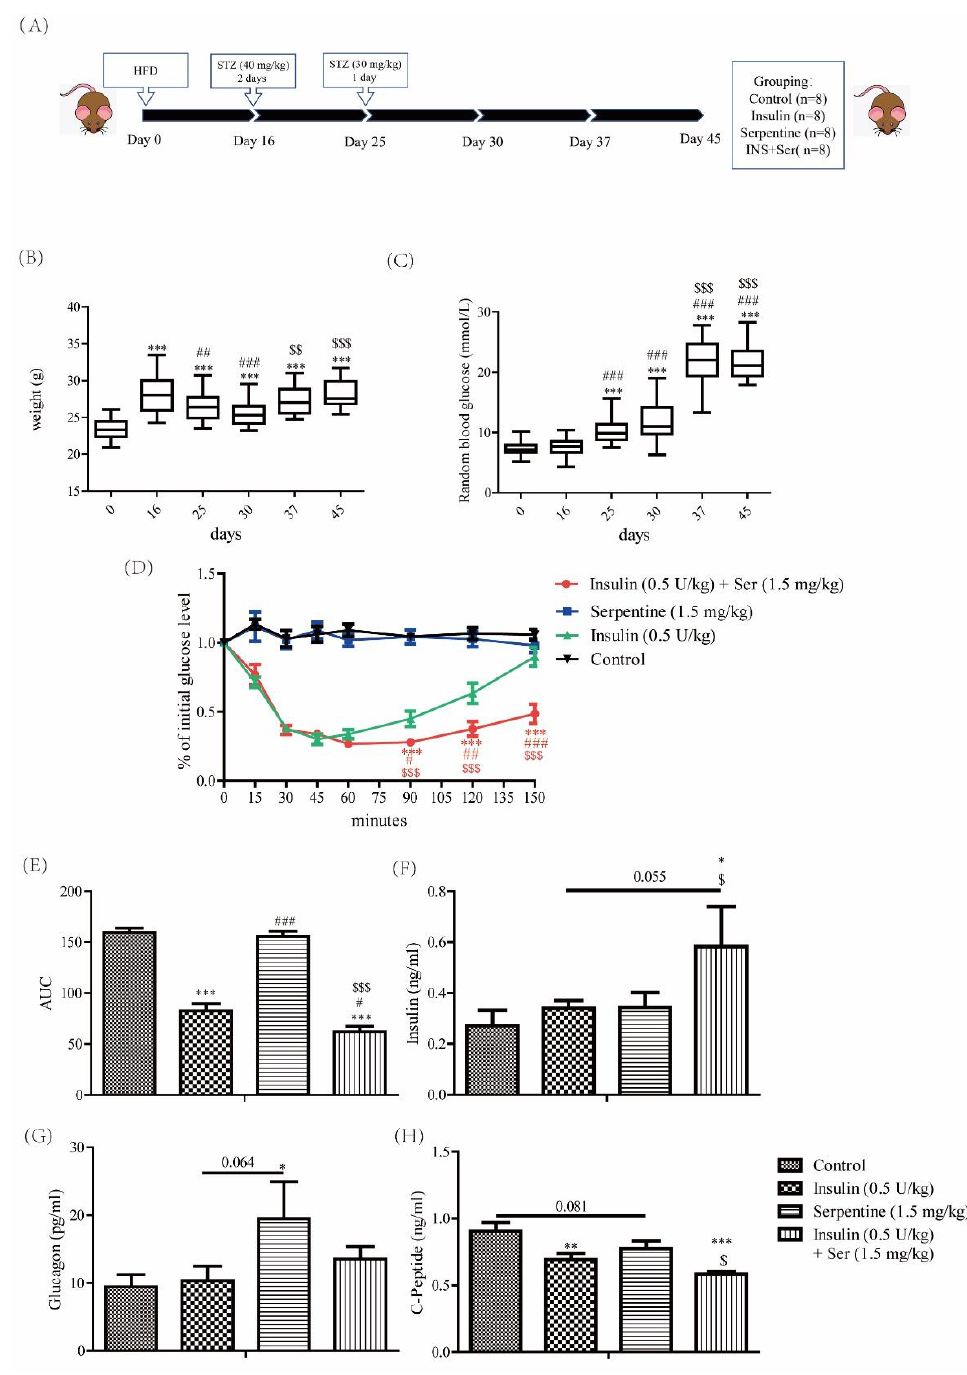
Figure 3. Effects of serpentine on blood glucose and hormone levels in an insulin-treated STZ-HFD-induced type 2 diabetes mouse model. ( A ) Time schedule for establishing the HFD/STZ-induced diabetic mouse model. Changes in body weight ( B ) and blood glucose ( C ) of mice during establishment of the animal model. Blood glucose changes within 150 min after insulin (0.5 U/kg) ( D ) and serpentine (1.5 mg/kg) ( E ) treatment, and AUC calculation. ( F ) Serum insulin, ( G ) glucagon, and ( H ) C-peptide levels in diabetic mice at 150 min. Data are expressed as mean ± SEM ( n = 8 in each group). In ( B ) and ( C ), *** p < 0.001 versus 0 days; ## p < 0.001, ### p < 0.001 versus 16 days ； $$ p < 0.01, $$$ p < 0.001 versus 30 days. In ( D ) and ( H ), * p < 0.05, ** p < 0.01, *** p < 0.001 versus control; # p < 0.05, ## p < 0.001, ### p < 0.001 versus insulin (0.5 U/kg); $ p < 0.05, $$ p < 0.01, $$$ p < 0.001 versus serpentine (1.5 mg/kg).